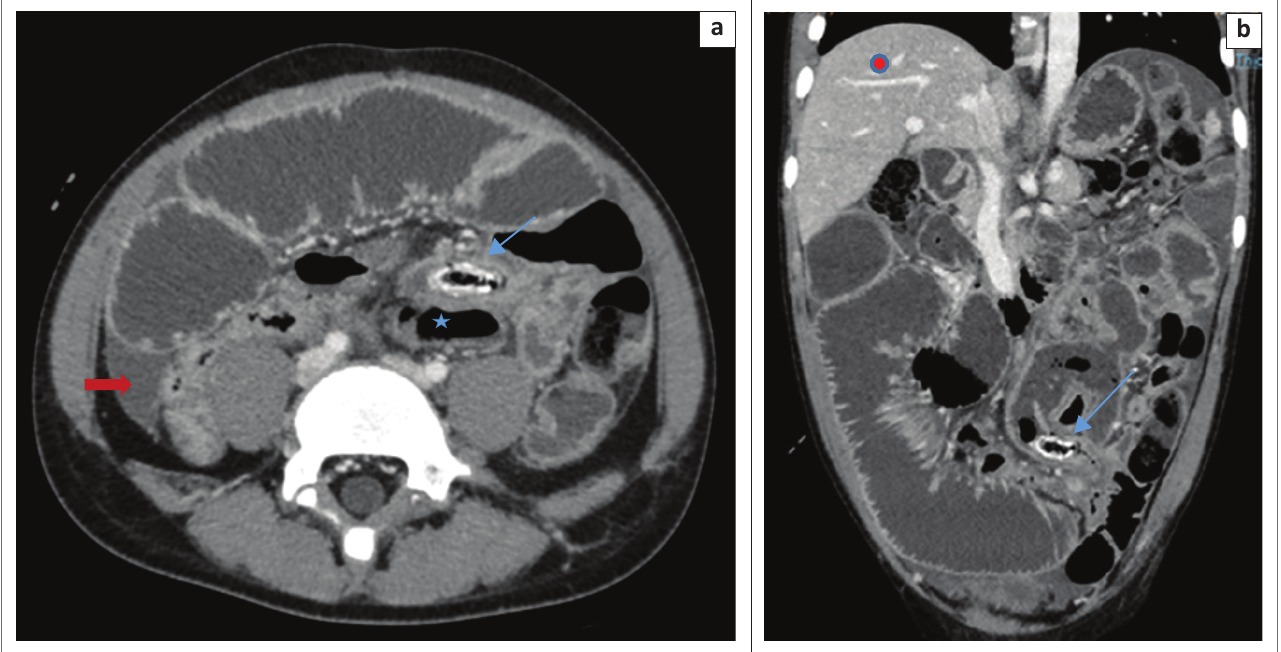
FIGURE 2: (a and b) Axial and coronal CT images demonstrating appendiceal wall thickening and enhancement with a faecolith (blue arrows) anterior and cephalad to the caecum (star). The right iliac fossa was unremarkable with fluid in the paracolic gutter (red arrow). Note the liver (red circle) is in the normal anatomic